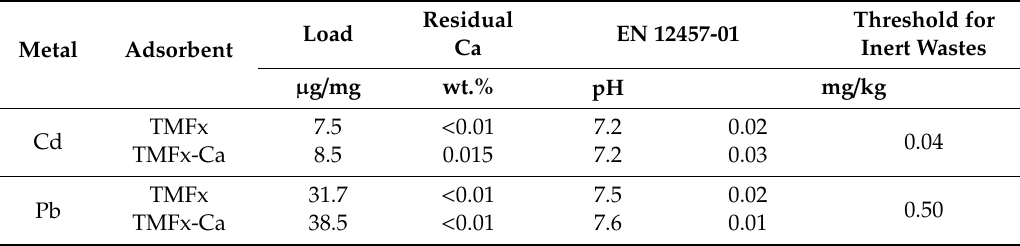
Table 5. Leaching characteristics of saturated TMFx and TMFx-Ca adsorbents after Cd and Pb sorption and removal from water, following RSSCT